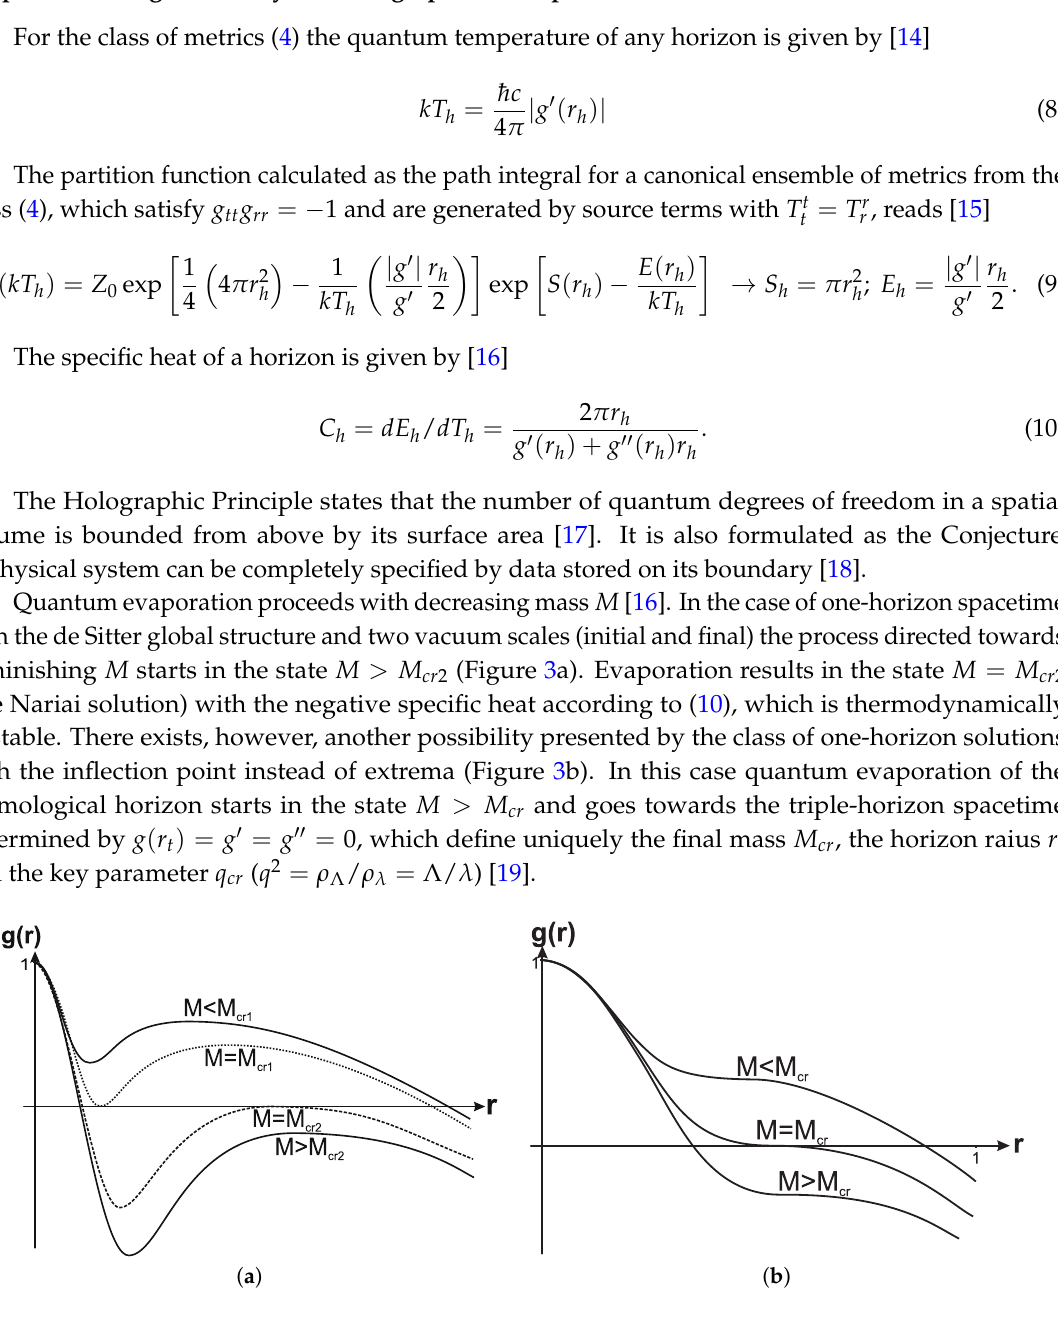
Figure 3. Two options for quantum evaporation of one-horizon